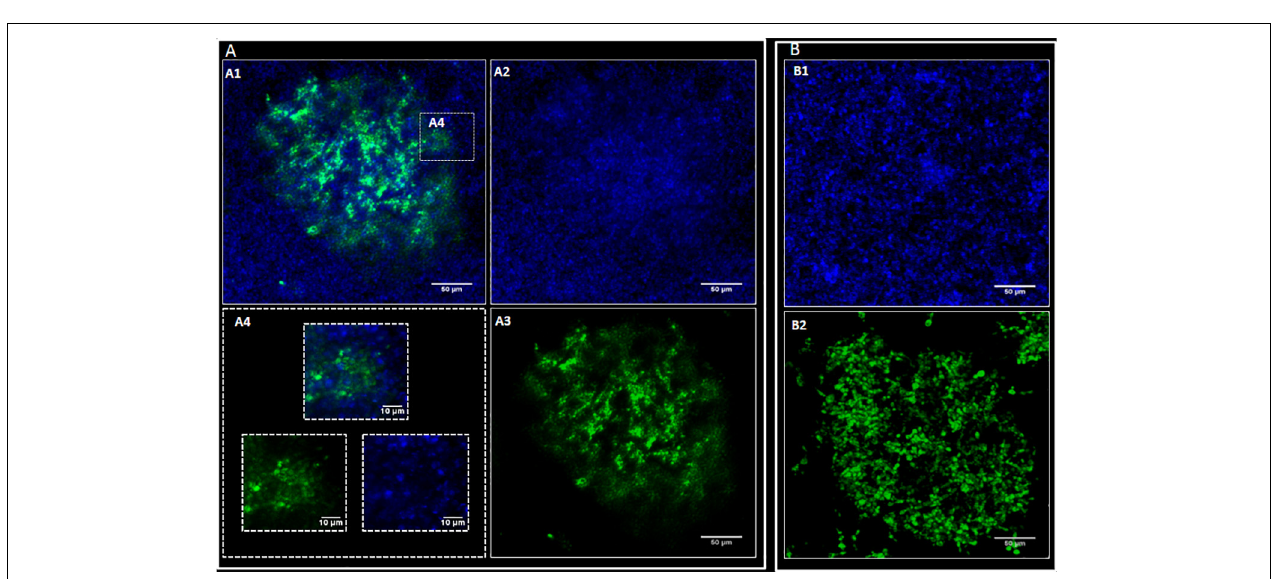
FIGURE 4 | Representative confocal microscopy images. P. brasiliensis was marked with CFSE (green) and C. albicans with Calcofluor white (blue). C. albicans (CA) and P. brasiliensis (PB) mono-species biofilms formed for 48 and 144 h, respectively. For dual-species biofilms, P. brasiliensis previously treated with CFSE was added to 12 h preformed C. albicans biofilm, and incubated for 120 h. (A) Dual-species biofilms: overlay of CA and PB (A1), CA (A2), PB (A3) and zoom in image showing dual-species interaction (A4); (B) Mono-species biofilms: CA biofilm (B1) and PB biofilm